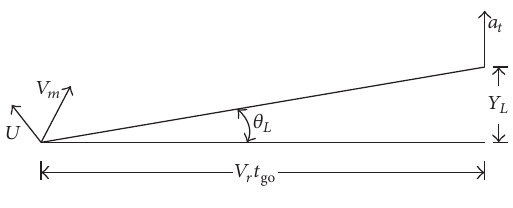
Figure 2: Illustration of small offset